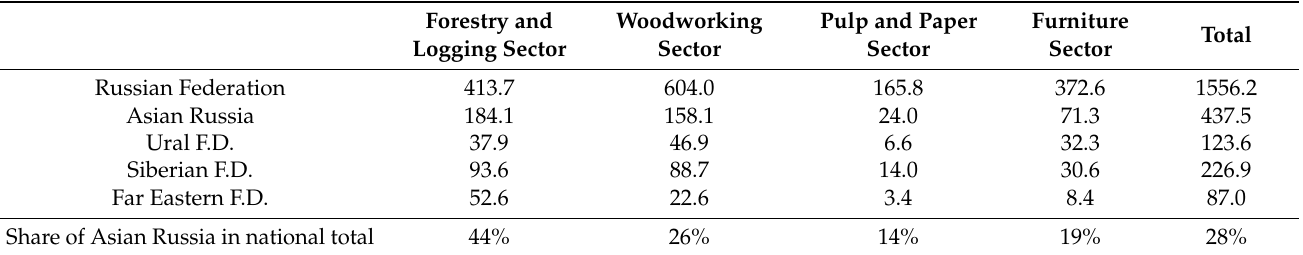
Table 6. The number of people employed in forest sector in Russia, Asian Russia and corresponding federal districts in 2021 by the type of economic activity, thousands. Forestry and Woodworking Pulp and Paper Furniture Total Logging Sector Sector Sector Sector 413.7 Ural F.D.